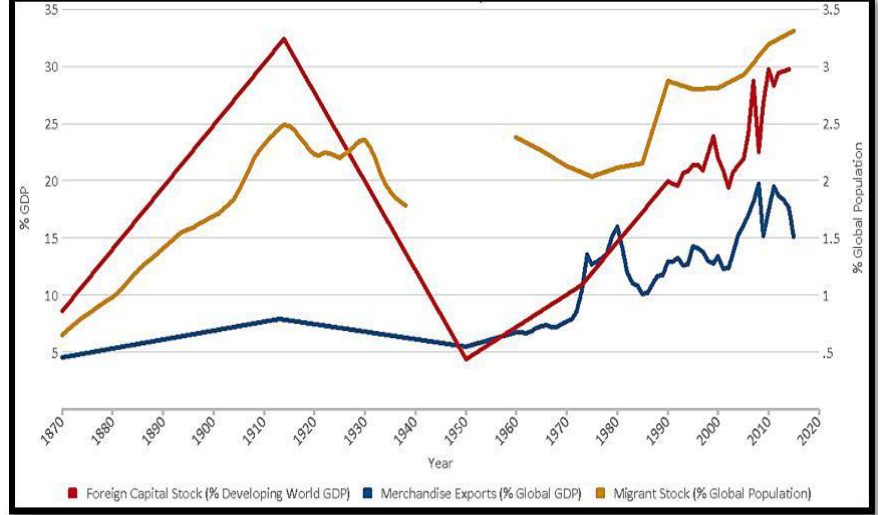
Figure 2: Globalization Trend 1870-2020 (Source: Rowe and Alexander